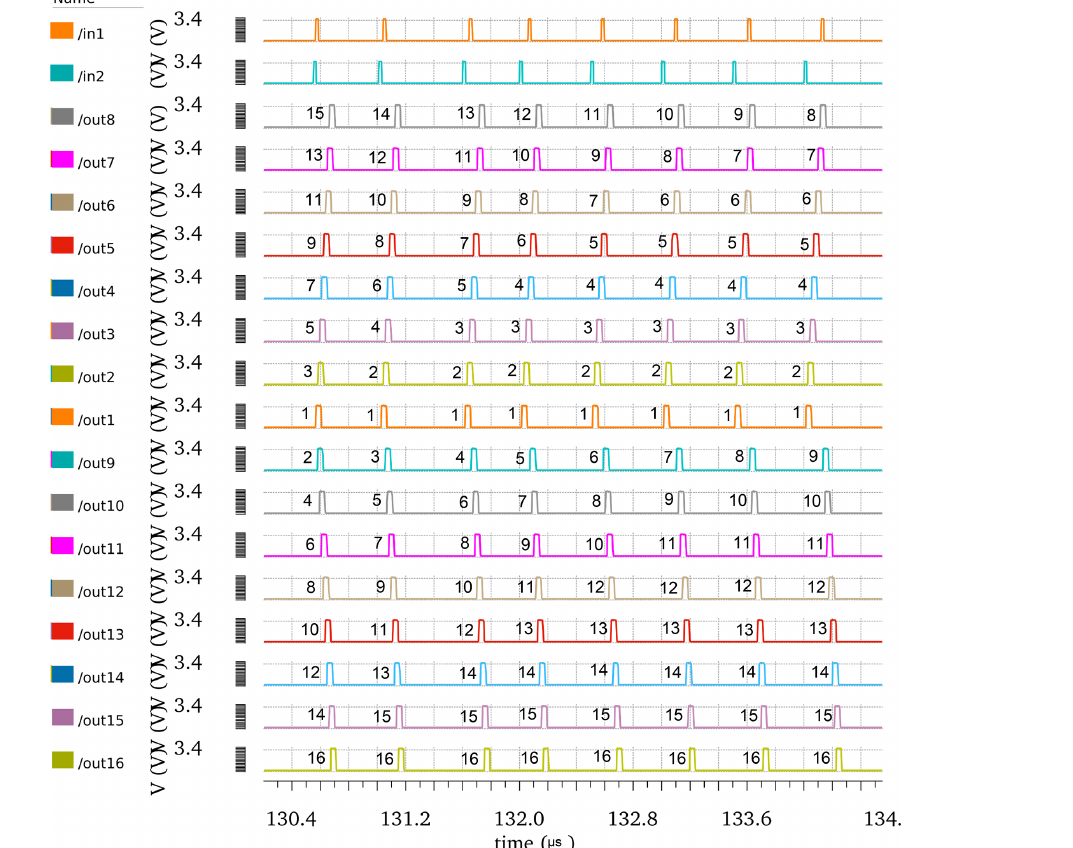
Figure 13. The simulation of adaptive spike-to-digital converter (ASRC) rank coding, with in2 preceding in1. It represents the outputs of the ASDC at circuit conditions, where V dd is 3.3V, and temperature is 27 ◦ C and on the nominal process. They are coded by spike order codes. Every column represents a different code and reflects the difference in time amount between the two spikes at